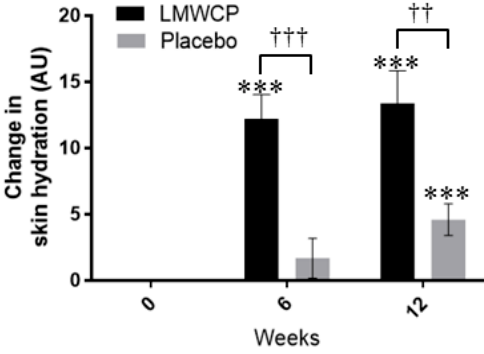
Figure 2. Changes in skin hydration in individuals receiving Low-molecular-weight Collagen peptide (LMWCP) preparation or placebo. Skin hydration was measured with a Corneometer CM825, and changes from baseline values are shown, with arbitrary units (AU). Data are expressed as the mean ± SEM. *** indicates a significant difference from the baseline ( p < 0.001; t -test). †† and ††† indicate significant differences between the test group and the placebo group ( p < 0.01 and p < 0.001, respectively; t